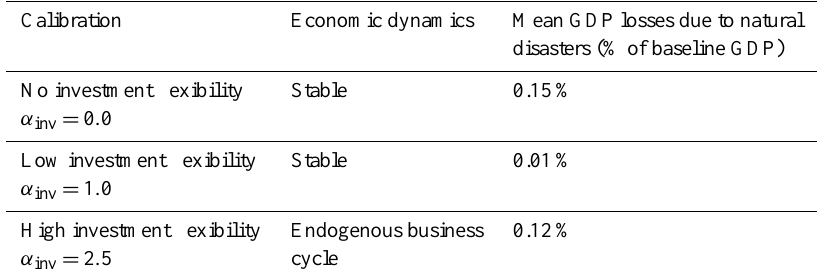
Table 4. Long-term averaged GDP losses due to the distribution of natural disasters for different types of economic